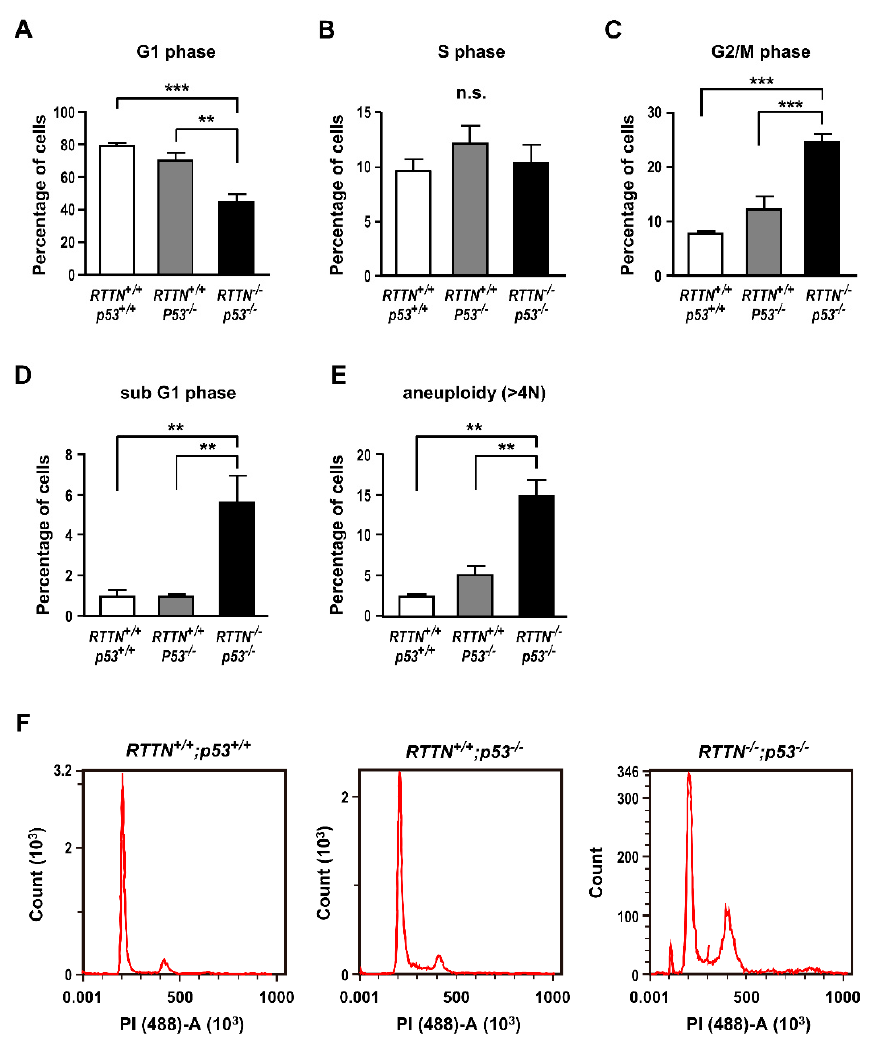
Figure 2. RTTN is required for proper mitotic progression. Flow cytometric analysis of cell cycle in RTTN +/+ ; p53 +/+ , RTTN +/+ ; p53 − / − , or RTTN − / − ; p53 − / − cells after PI staining to measure the percentages of cells in G1 phase ( A ), S phase ( B ), G2/M phase ( C ), sub-G1 phase ( D ), and the cells with aneuploidy (>4 N) ( E ). ( F ) A representative chart of flow cytometric analysis. Data were analyzed by one-way ANOVA with Tukey’s multiple comparison test. Data are represented as the mean ± SEM from six independent experiments. *** p < 0.0001; ** p < 0.01. n.s. not significant.